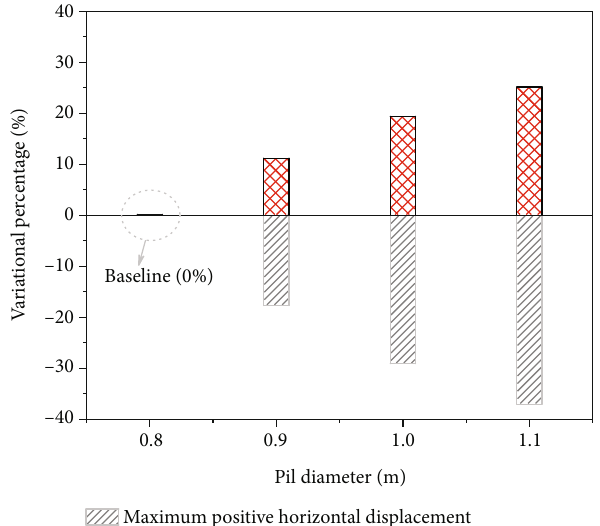
Figure 20: Variations of the maximum positive horizontal displacement and maximum bending moment of the end- suspended pile at di ff erent pile